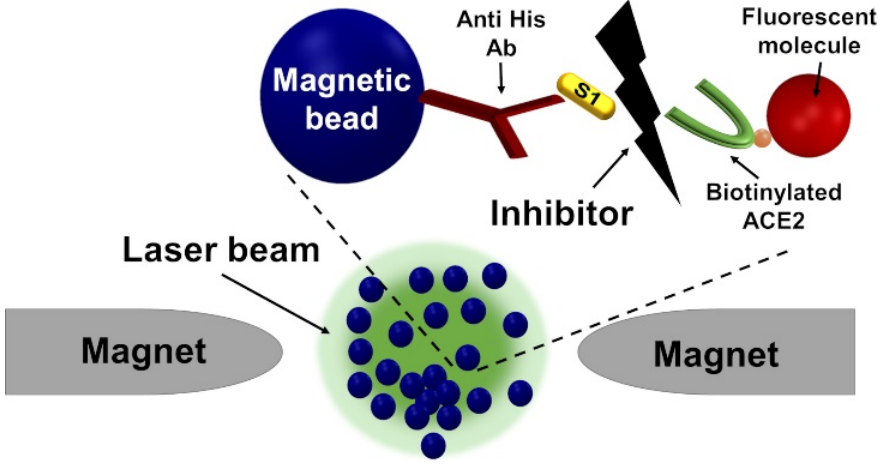
Figure 9. Schematic of using the MMB system for screening inhibitors of the S1-ACE2 interaction in SARS-CoV-2. From [41] with permission of MDPI 2021.